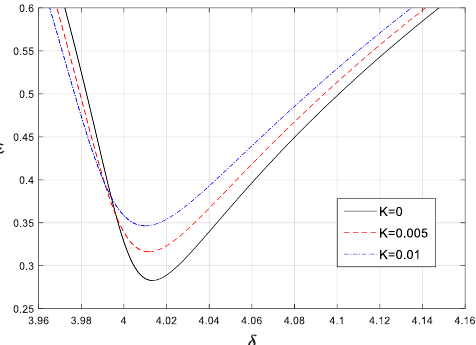
stiffness and the equivalent damping of the fractional-order derivative were both gradually increasing. In addition, when the fractional-order differential coefficient K was selected as 0.005 and the fractional-order differential order p was selected as 0, 0.5, and 0.8, respectively. The stability boundaries were as shown in Figure 11. It can also be seen that with the increase in p , due to the equivalent stiffness decreasing and the equivalent damping increasing, the stability boundaries moved upward and the position obviously shifted to the right. In short, we found that the fractional-order derivative not only affects the position of the stability boundaries but also changes the range of the stability region.